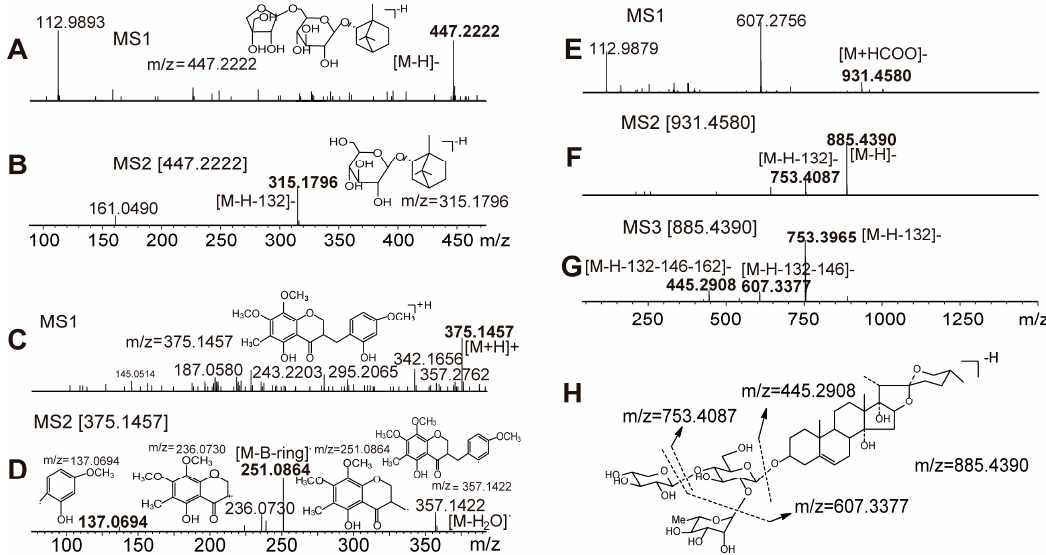
Figure 2. MS spectra of L -borneol-7- O -[ β - D -apiofuranosyl(1 → 6)]- β - D -glucopyranoside, 5,2 ′ -dihydroxy-